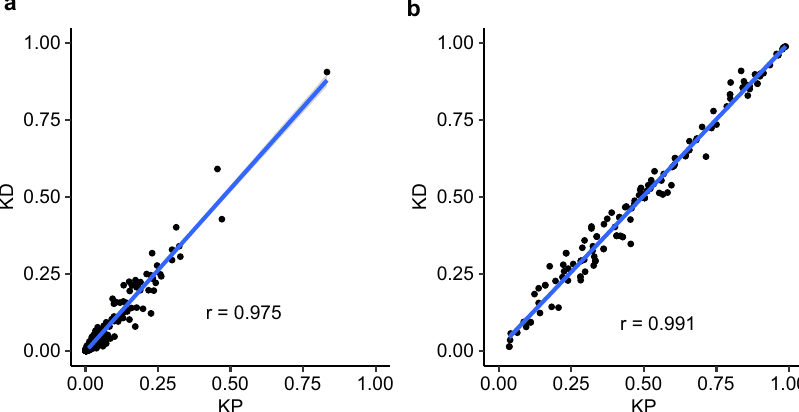
Fig. 5 Pairwise analysis between patient and donor HLA allele and eplet frequencies. Relative frequencies were calculated as the proportion of subjects expressing a particular allele or eplet. The line and correlation coef fi cient were calculated using Pearson correlation. a Each dot represents an allele and its frequency for patients ( n = 1049) is plotted on the x axis and its frequency for donors ( n = 797) is plotted on the y axis. b As above but for eplets. KP kidney patients, KD kidney